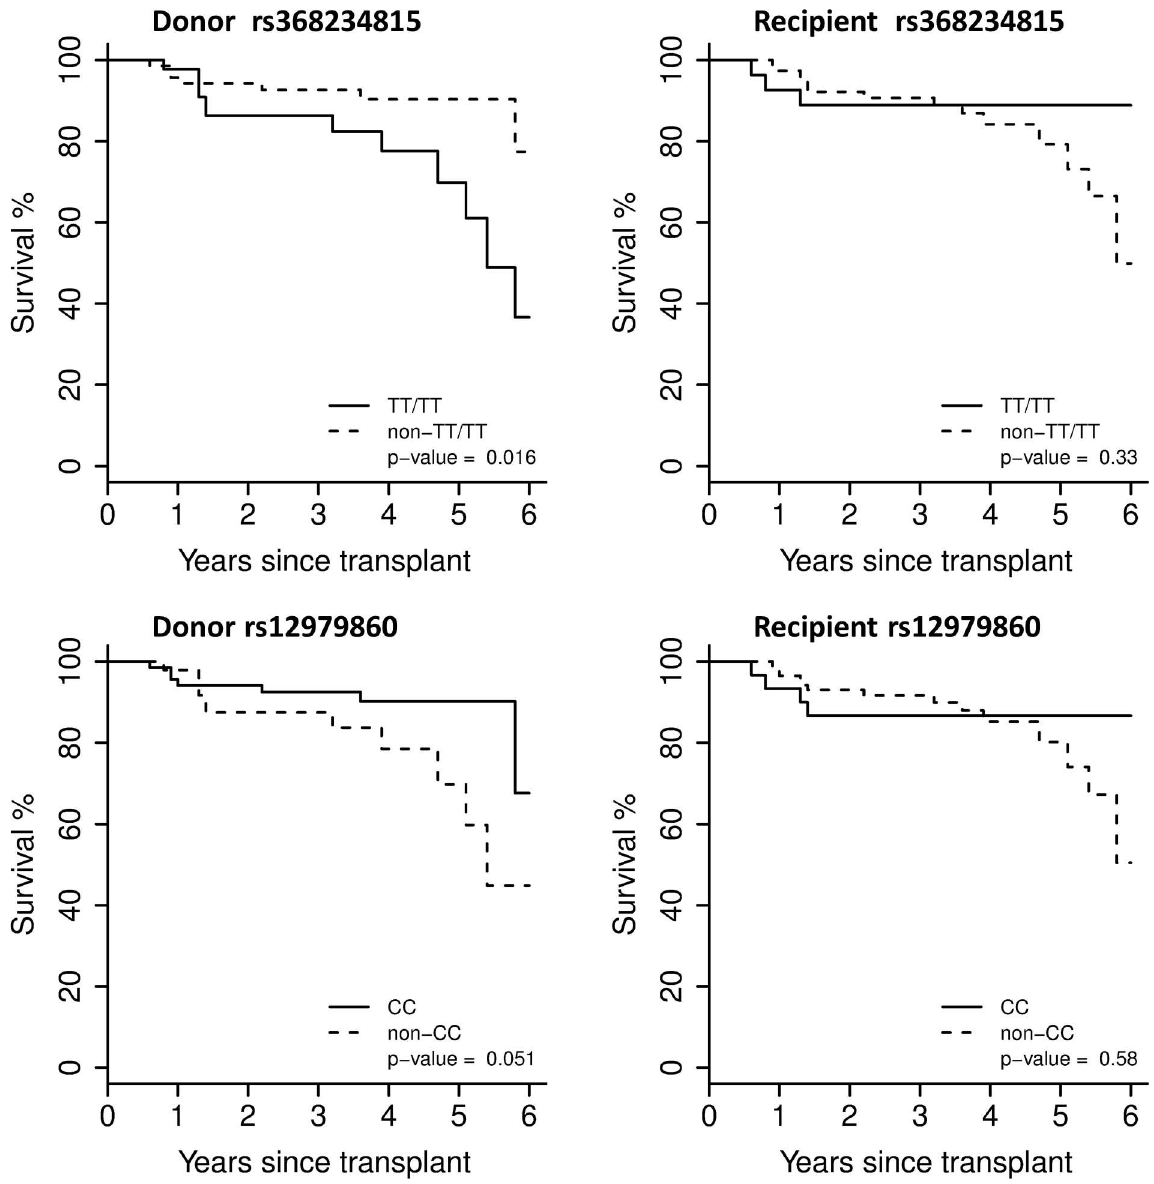
Fig 2. Kaplan-Meier curves for donor/recipient rs368234815 genotype and donor/recipeient rs12979860